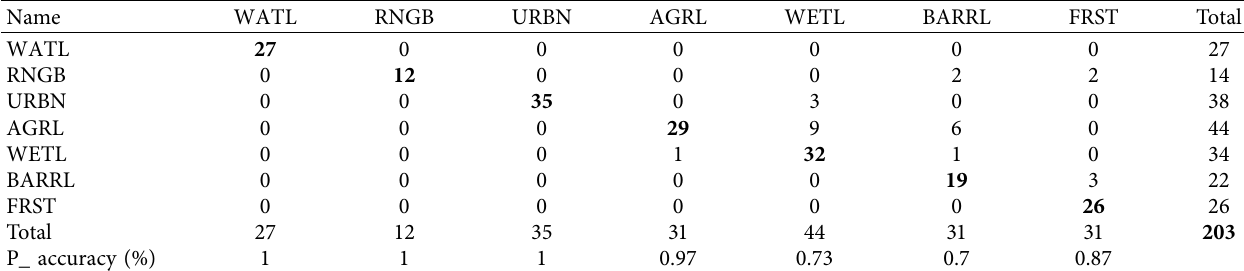
Table 4: Land use and land cover map confusion matrix.